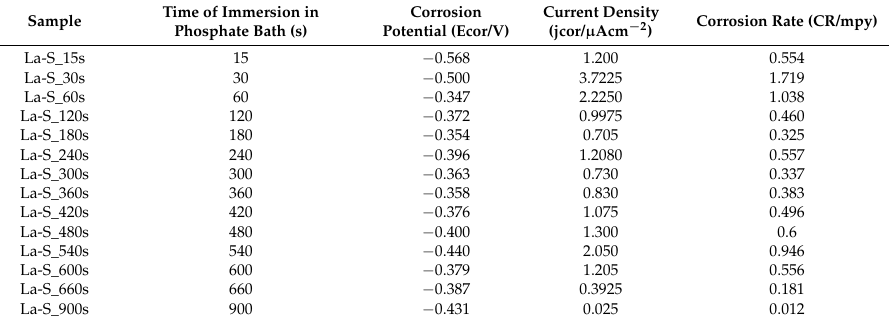
Figure 2. Polarization curves for selected La-S samples. Table 3. The values of corrosion potential, current density, and corrosion rate estimated for La-S samples treated for various times in a phosphate